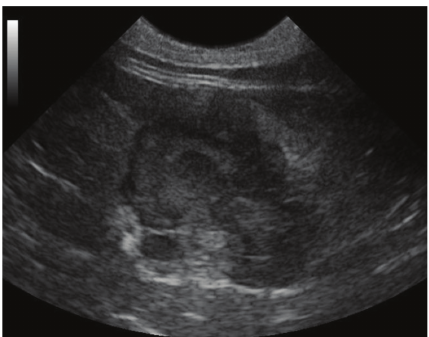
Figure 1: Ultrasonographic appearance of the pancreatic lesion: the ultrasonogram shows a hypoechoic mass containing hyperechoic and hypoechoic areas.